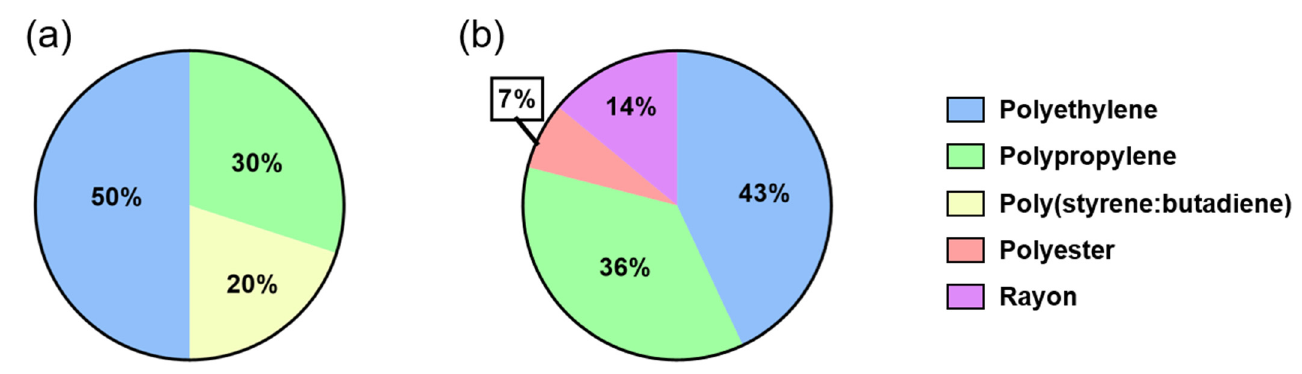
Figure 7. Microplastic polymer identified in water ( a ) and sediment ( b ) samples.